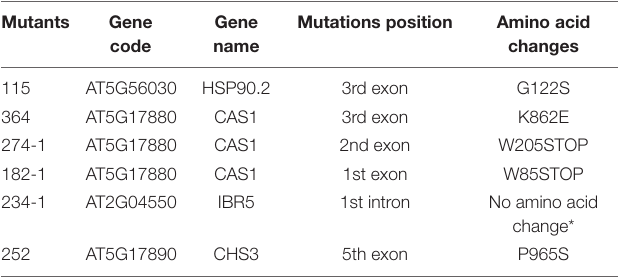
TABLE 1 | Mutations in the six chs3-2D suppressor mutants. Mutants